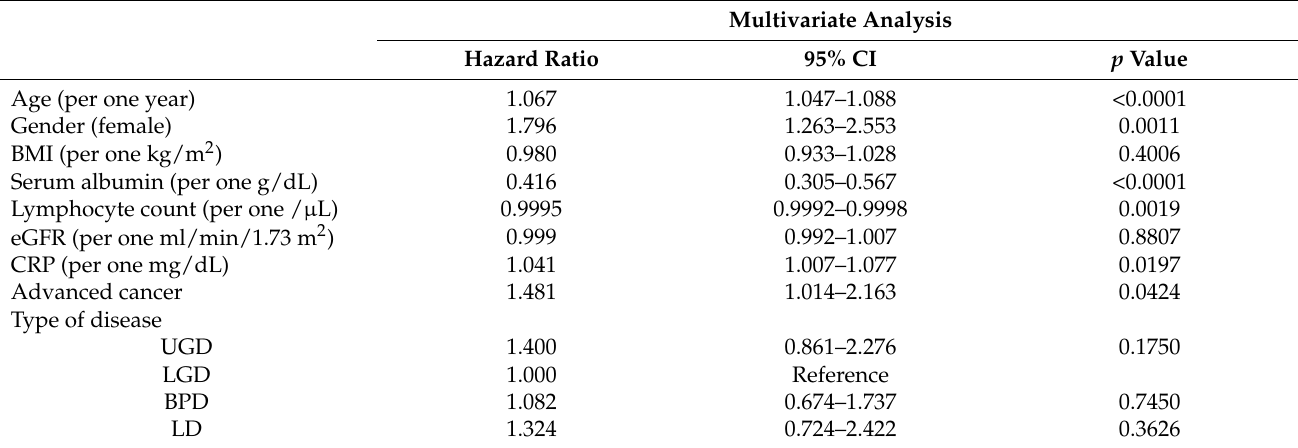
Table 4. Multivariate analysis of factors linked to SARC-F ≥ 4